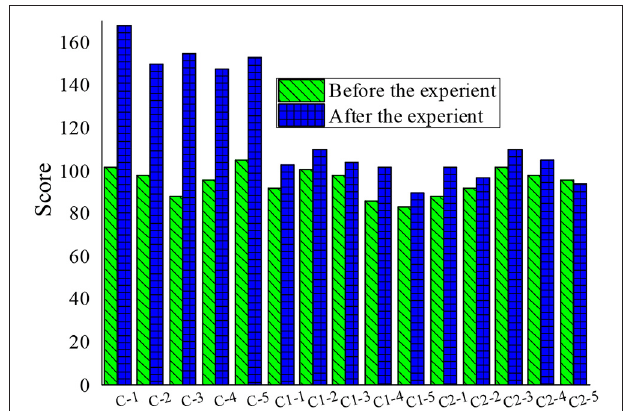
TABLE 5 | Comparison of piano teaching effects among groups in grade 2.